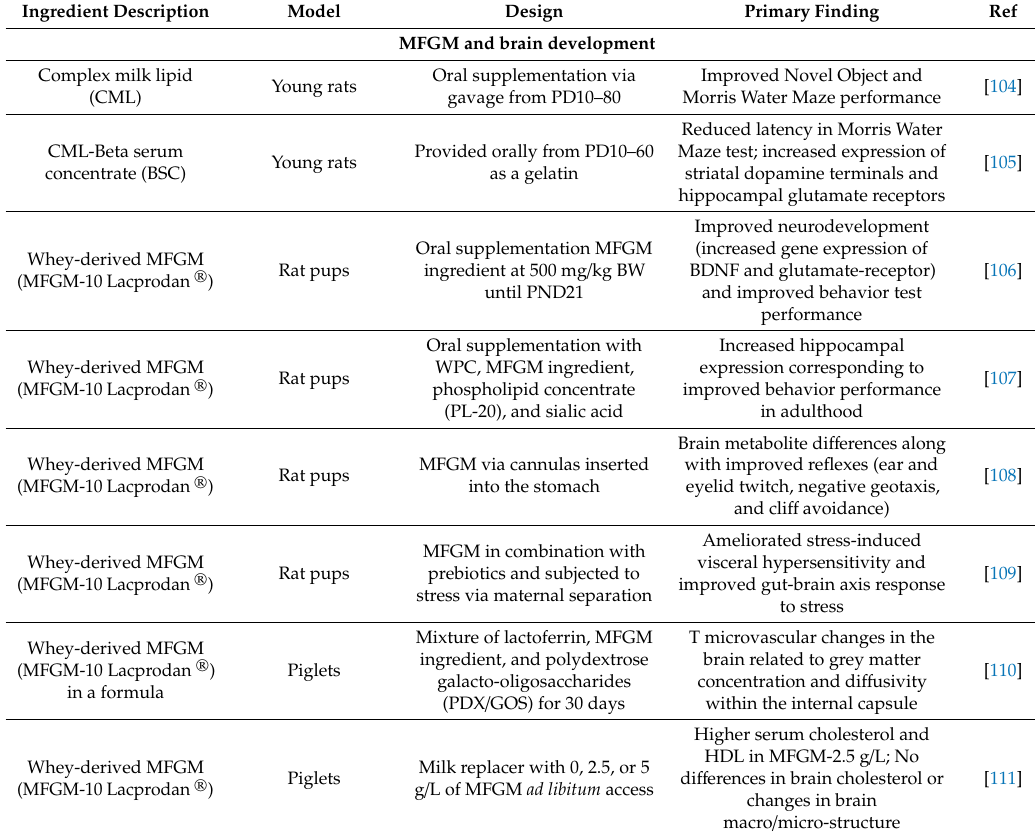
Table 4. In vivo evidence on MFGM ingredients for brain, intestine / immune, and microbiome development (adapted from ref